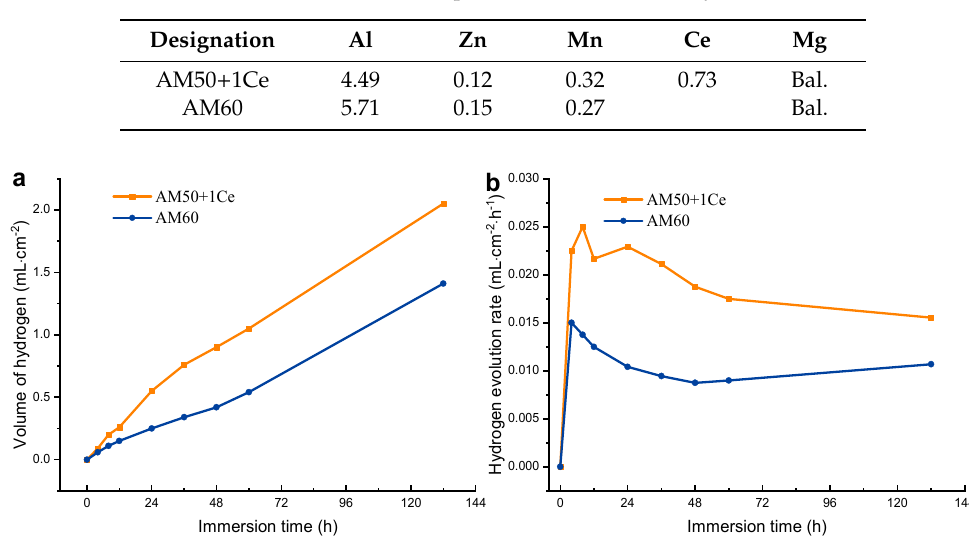
Figure 5. Volume of hydrogen evolved ( a ) and hydrogen rate ( b ) for HPDC AM series Mg alloys during 132 h immersion in 3.5 wt% NaCl